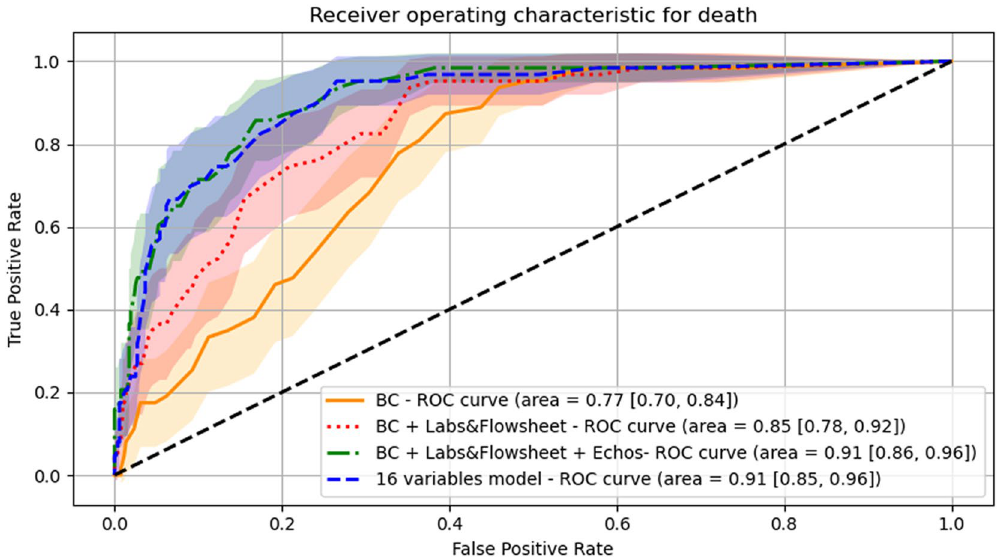
Figure 1. Receiver operator characteristic (ROC) curve for the prediction of death in the study cohort. AUC for the model using baseline characteristics (BC) is shown in orange and yellow for confidence intervals. AUC for the model using baseline characteristics in addition to laboratory data and vital signs (flowsheet) is shown in red and pink for confidence intervals. AUC for the model using baseline characteristics + laboratory data and vital signs (flowsheet) + echocardiographic measurements is shown in blue and shades of blue for confidence intervals. AUC for the optimized prediction model using 16 variables encompassing data from baseline characteristics, vital signs, and echocardiographic measurements is shown in green and shades of green for the confidence intervals.